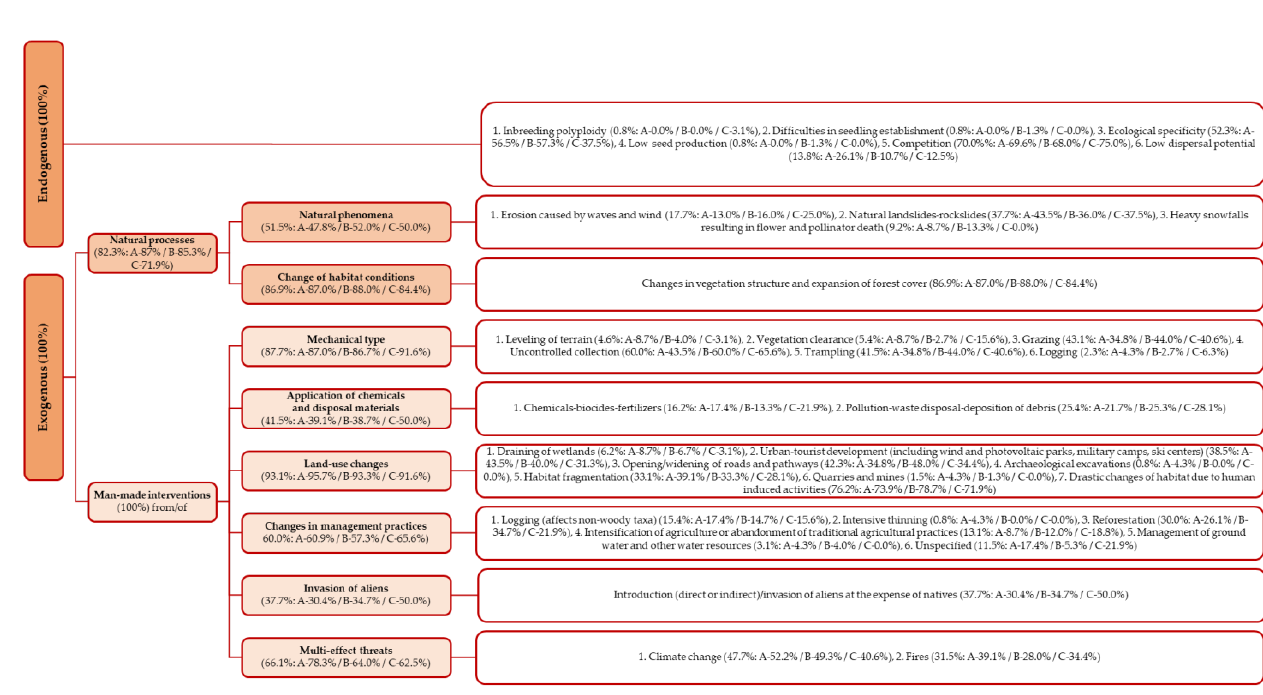
Figure 4. Classification of risks and threats identified in-situ for the 130 priority plants in the cross- border area of Greece and the Republic of North Macedonia (Supplementary Material Table S2). In parentheses, the percentage of plant taxa affected is shown (first number for all 130 PPs; A, for pri- ority category A taxa; B, for priority category B taxa; C, for priority category C taxa).